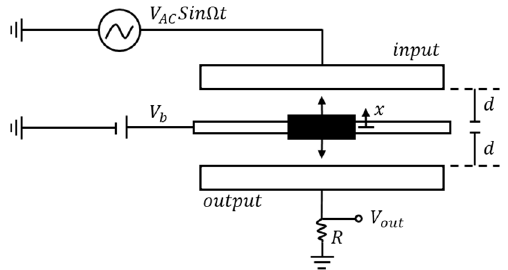
Figure 1. Simplified diagram of a bilateral MEMS resonator.